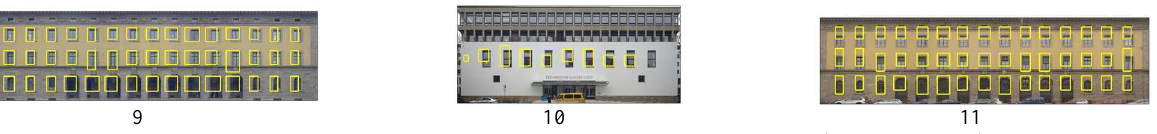
Figure 8. Textures and reconstructed windows for façade parts 9 to 11 (from left to right)